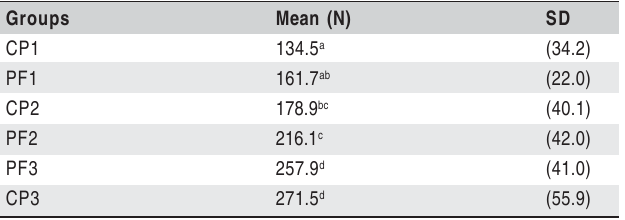
Table 1. Resistance to failure values of test specimens, means (N) of test groups (standard deviation) and statistical comparisons Groups